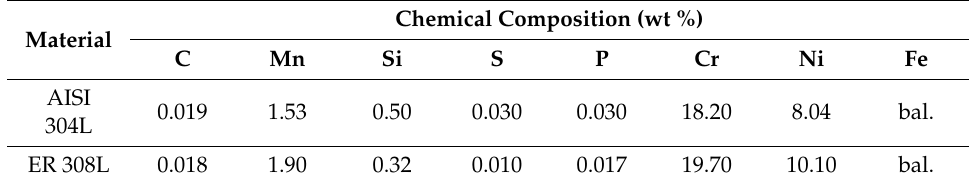
Table 1. Chemical compositions of the 304L steel plate and 308L weld metals used in this study.